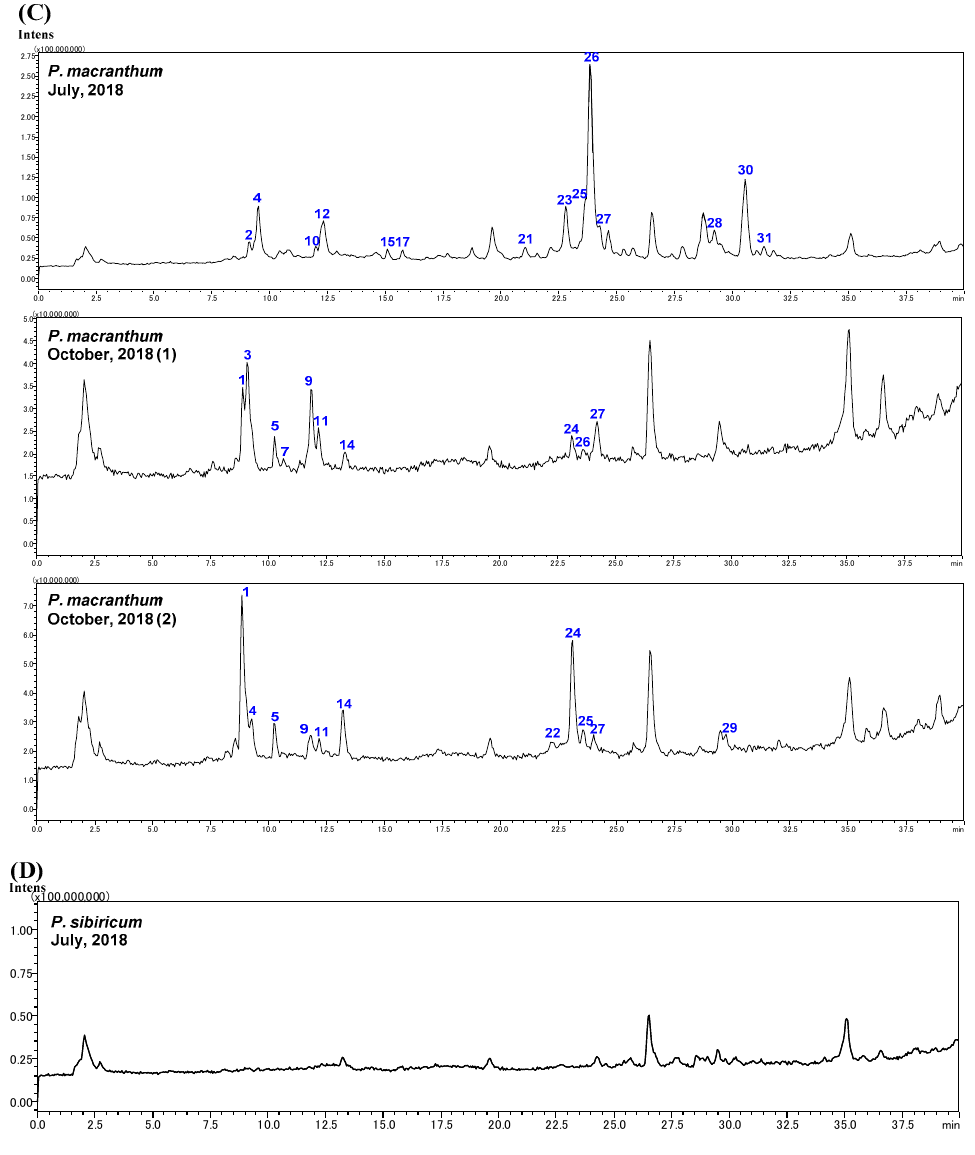
Figure 3. Total ion chromatograms of the extracts from the rhizomes of four Polygonatum species in the positive-ionization mode. ( A ) P. odoratum . ( B ) P. falcatum . ( C ) P. macranthum . ( D ) P. sibiricum .